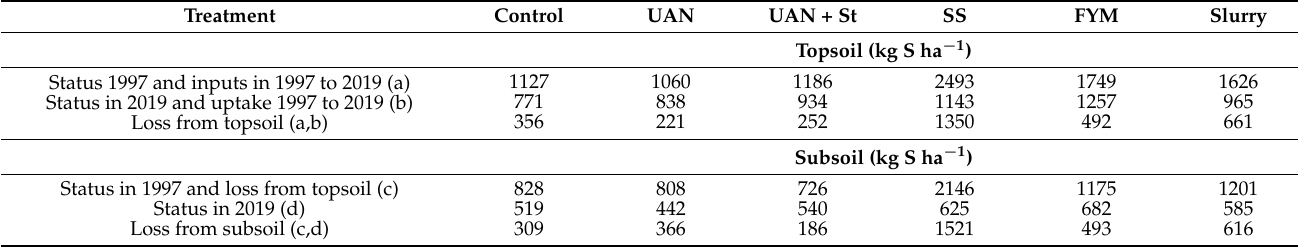
Table 12. Movement of sulfur in topsoil and subsoil during the